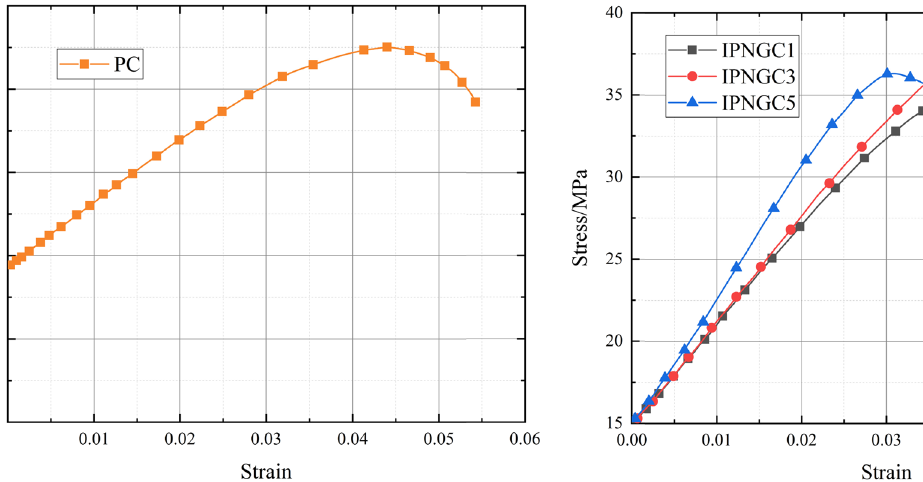
Figure 7: PC stress – strain curve.